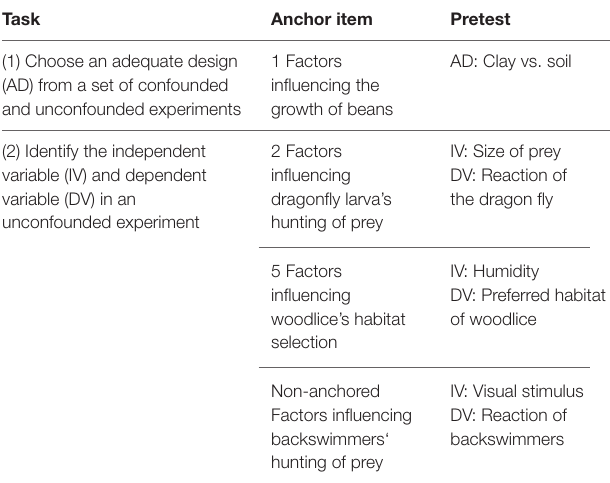
TABLE 2 | Anchor and non-anchored items of